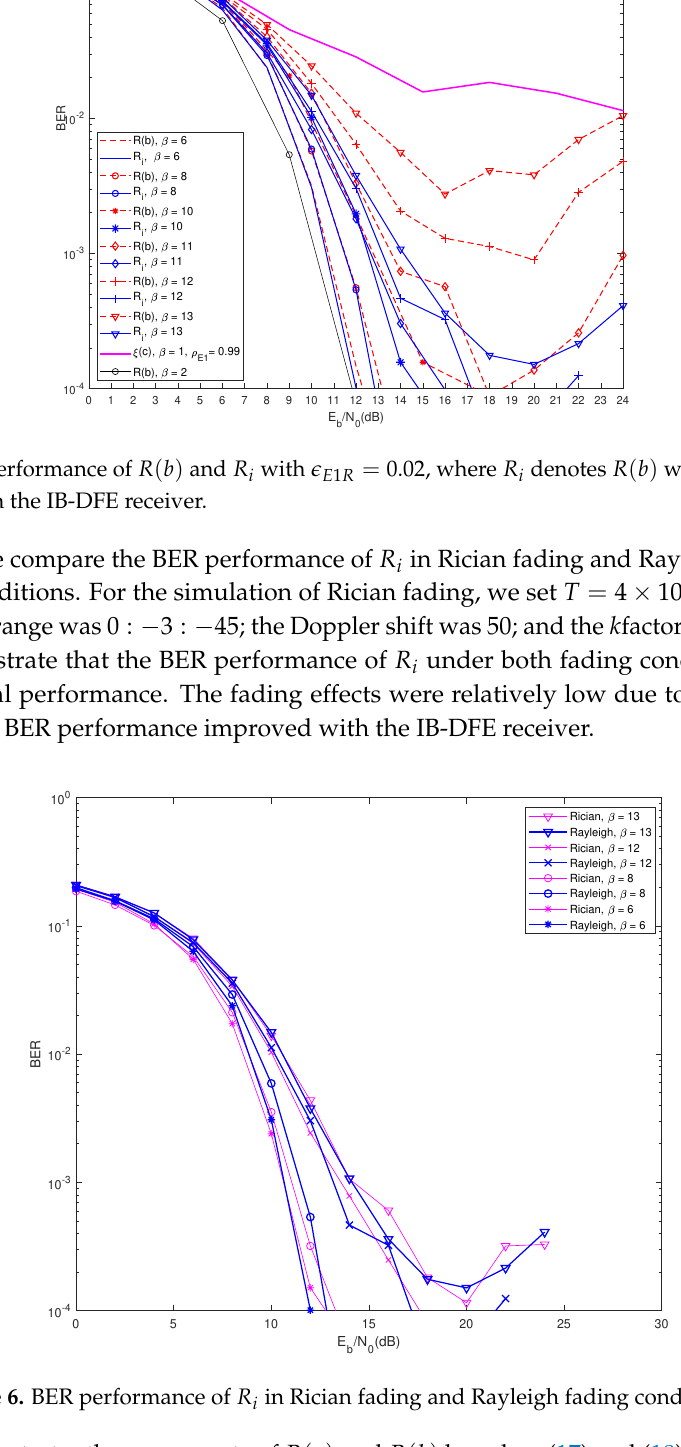
Figure 4. BER performance of ξ in all the scenarios with e E 1 R = 0.02 in scenario B .